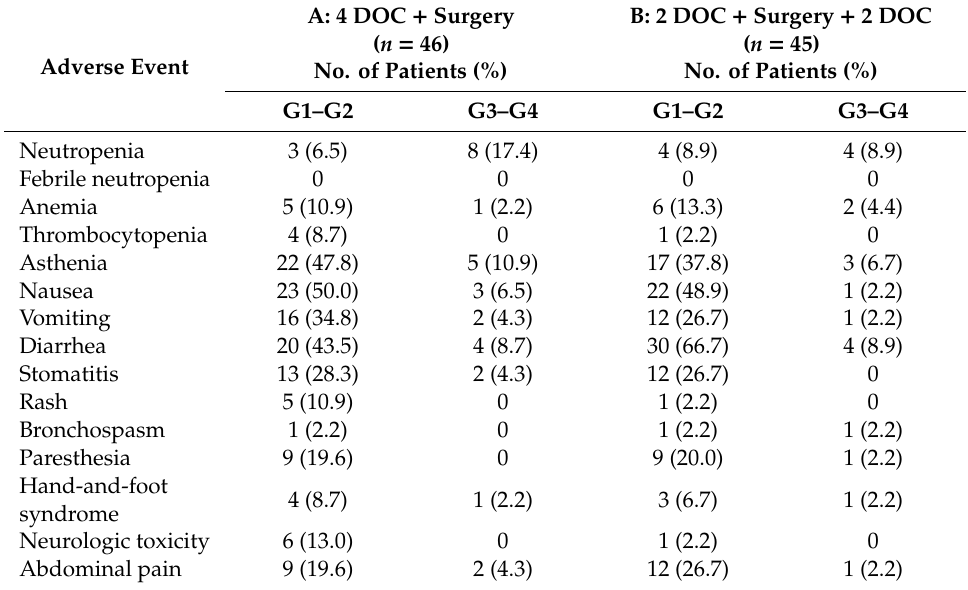
Table 3. Targeted adverse events reported by patients with at least one cycle of treatment.